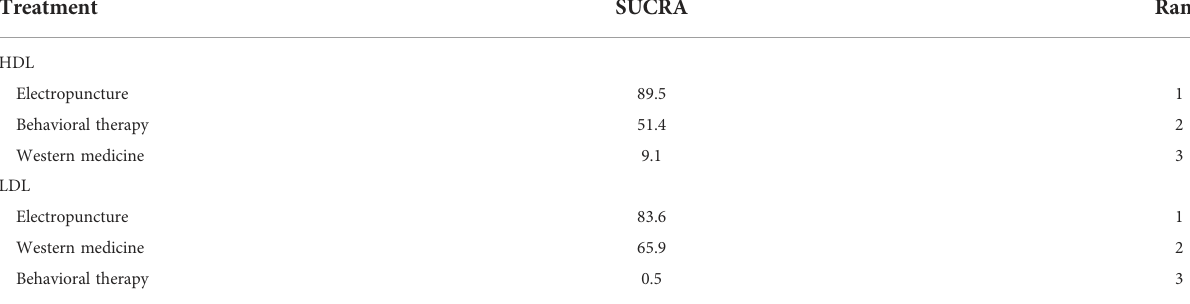
TABLE 13 Ef fi cacy ranking of mesh meta-analysis: high-density lipoprotein (HDL) and low-density lipoprotein (LDL).